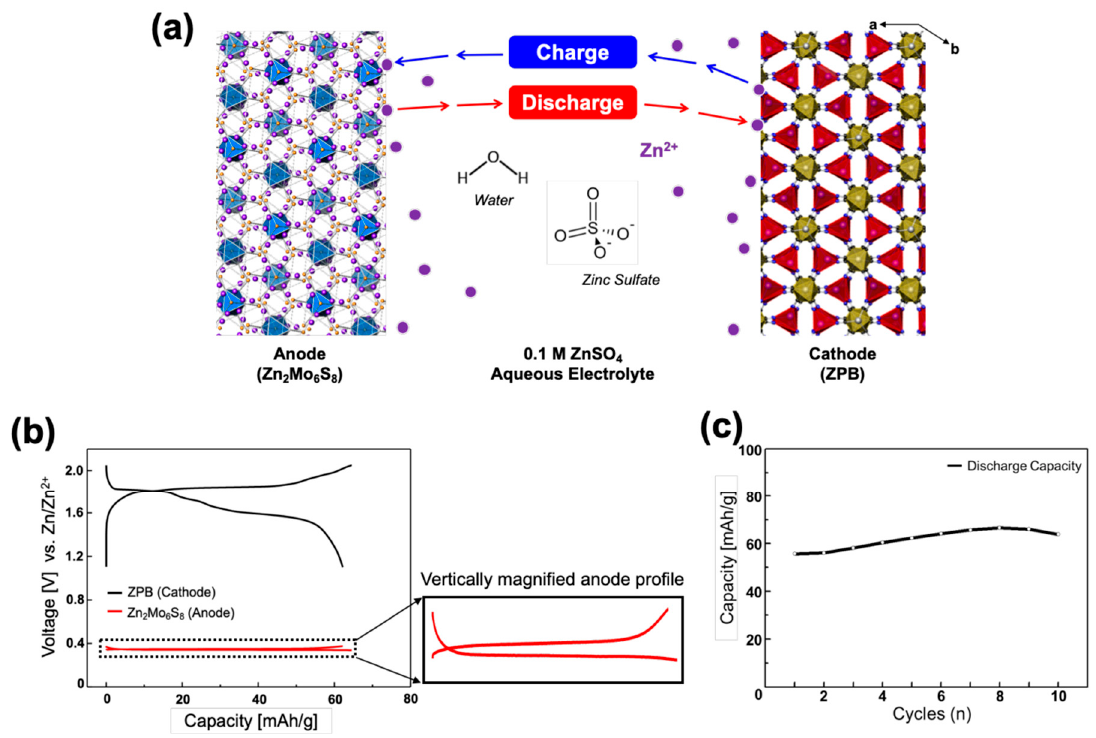
Figure 6. ( a ) Illustration of the compositions for the rocking-chair zinc-ion battery: Zn 2 Mo 6 S 8 as an anode and ZPB as a cathode. ( b ) Initial discharge-charge profiles of a Zn 2 Mo 6 S 8 /ZPB cell at 0.2 C rate with the zinc metal reference electrode. The vertical magnification of the anode profile is ~13 times. ( c ) Cycling performance of Zn 2 Mo 6 S 8 /ZPB cells at 0.5 C rate.